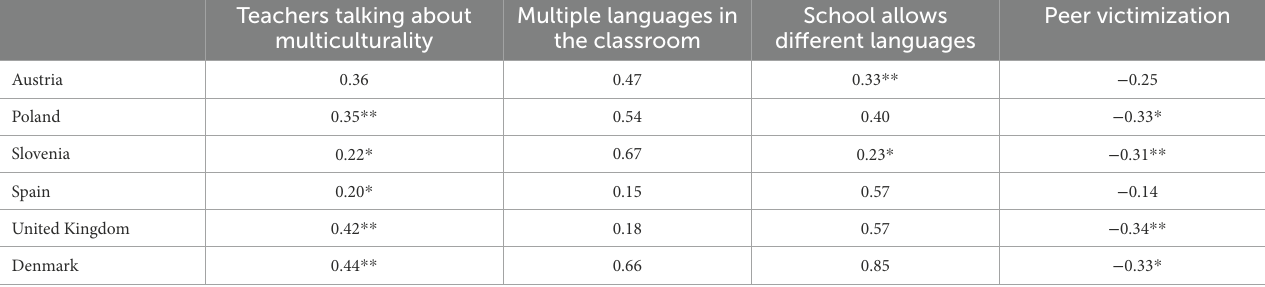
TABLE 6 Correlation statistics between school well-being and teaching practices/peer victimization. Teachers talking about Multiple languages in School allows Peer multiculturality the classroom different languages